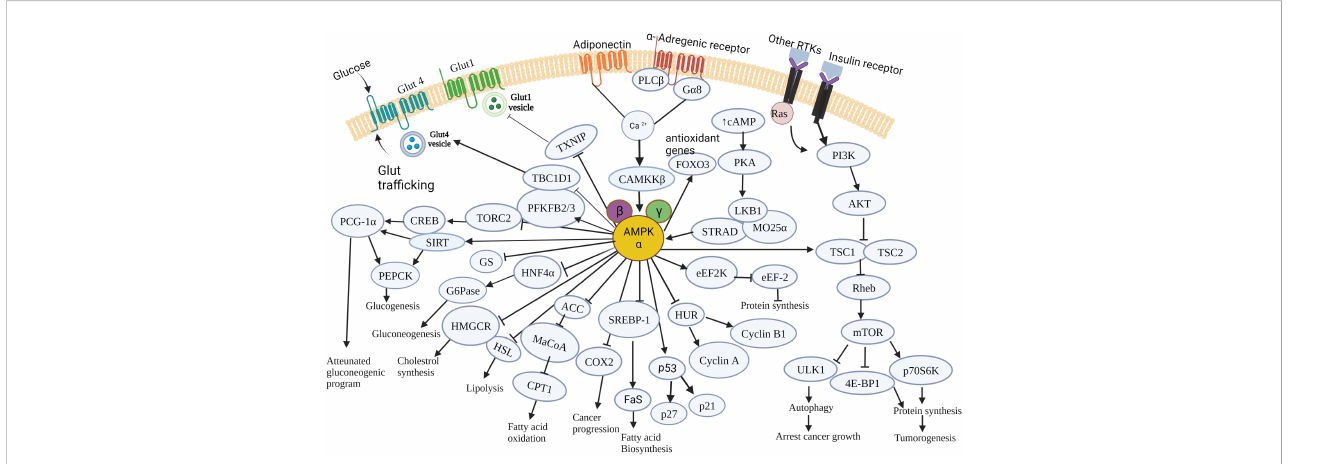
FIGURE 3 Schematic illustration of the major molecular targets of AMPK and the down-stream signaling events orchestrated by AMPK in cancer cell metabolism. AMPK controls various metabolic pathways that are critical to tumorigenesis and cancer progression. It regulates major cellular events governing cancer cell growth, survival and proliferation and pathways involved in glucose, lipid and protein metabolism. AMPK, AMP-activated protein kinase; mTOR, mammalian target of rapamycin; Glut4, Glucose transporter type 4; Glut1, Glucose transporter type1; RTK, Receptor tyrosine kinase; PLC- b , Phospholipase C- b ; G6Pase, Glucose -6-phosphatase; HMGCR, Hydroxymethyl glutaryl-CoA reductase; HSL, Hormone sensitive lipase; cAMP, Cyclic adenosine 3 ’ ,5 ’ -monophosphate; PI3K, Phosphoinositide 3-kinase; Akt, A protein-serine/threonine kinase; CAMKK b , Ca 2+ /Calmodulin-dependent protein kinase kinase 2; PGC1 a , PPARG coactivator 1 a ; HNF4 a , hepatocyte nuclear factor 4 alpha; ACC, acetyl-CoA carboxylase; MaCoA, malonyl CoA; CPT1, Carnitine palmitoyl transferase 1; TSC1, Tuberous sclerosis complex 1; TSC2, tuberous sclerosis complex 2; Rheb – Ras homolog enriched in brain; SREBP1, Sterol regulatory element – binding protein 1; COX2, Cyclooxygenase-2; FaS, Fatty acid synthase; ULK1, unc-51-like kinase 1;p70S6K,70-kDa ribosomal protein S6 kinase; 4EBP1, eIF4E-binding protein 1;HuR,Human antigen R;LKB1,Liver kinase B1; eEF2K,eukaryotic elongation factor 2 kinase; eEF2K, eukaryotic elongation factor 2; PFKFB2/3,6-phosphofructo-2-kinase/fructose -2,6 – biphosphatase 2/3; TBC1D1- tre-2/USP6,BUB2,cdc16 domain family member 1;TXNIP, Thioredoxin interacting protein; CREB, cAMP response element - binding protein; SIRT, Sirtuin; PEPCK, Phosphoenol pyruvate carboxykinase; TORC2, target of rapamycin complex 2; STRAD, STE20-related adaptor protein; MO25 a , Mouse protein 25 a ; FOXO3, Forkhead box family transcription factor 3; PKA, cAMP-activated protein kinase; GS, Glycogen synthase; Ras, rat sarcoma viral